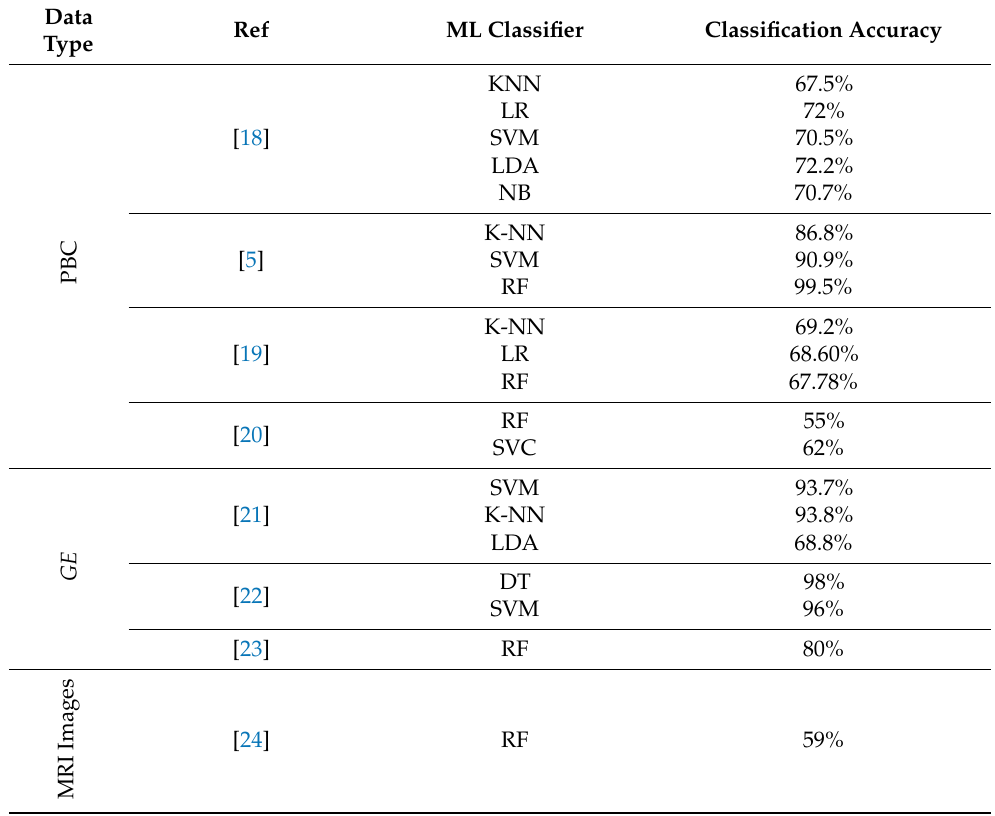
Table 1. ASD prediction using ML without FS.